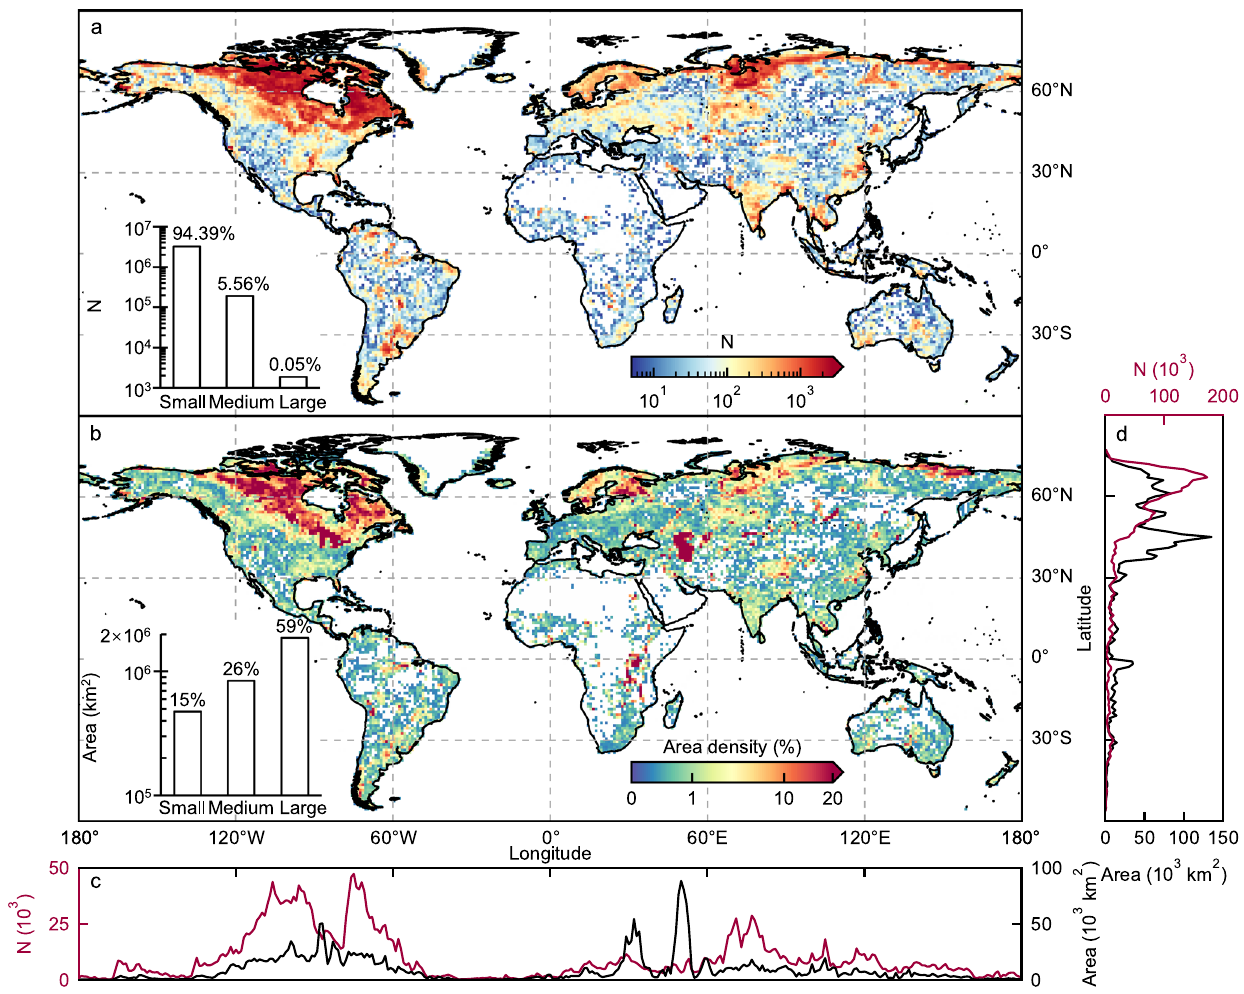
Fig. 1 | Spatial distribution of global lakes. Lakes with maximum surface area >0.03km 2 were mapped, showing a lake count (total number of lakes) and b lake area density (total lake area/grid area) per 1°×1° grid cell. The longitudinal and